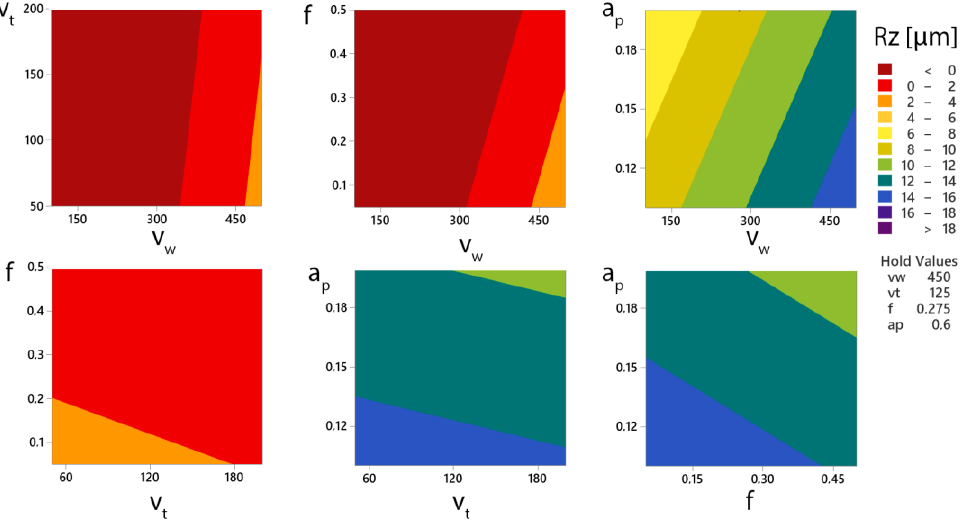
Figure 12. Contour (surface) plot of the parameter dependence on the roughness parameter